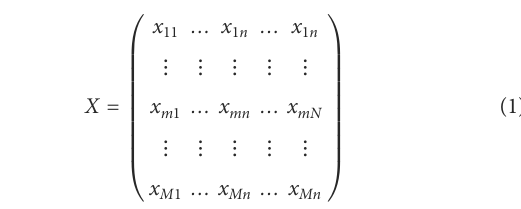
FIGURE 1 Three typical Kuroshio paths south of Japan: nNLM (red line), oNLM (green line), and tLM (blue line) derived from a regional ocean reanalysis described in section 2.1. Thin black contours are isobaths of 1 000 and 2 000